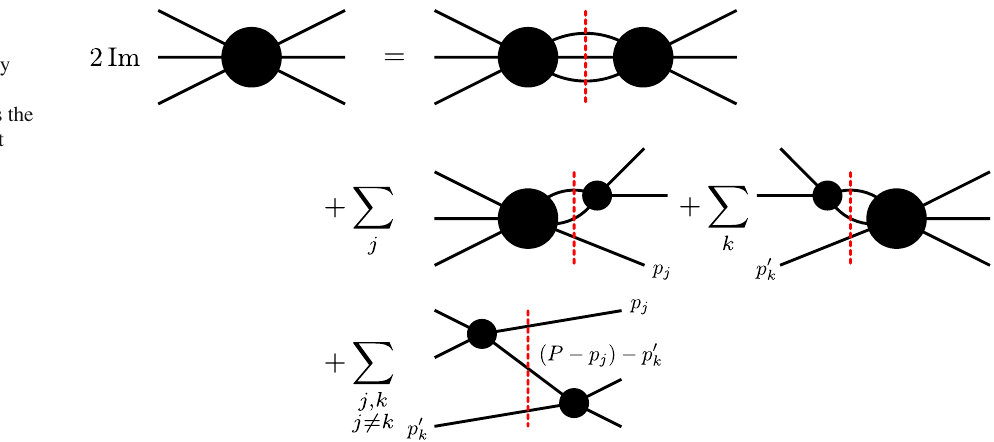
Fig. 5 Diagrammatic representation for the 3 → 3 connected amplitude unitarity relation in Eq. (8). The red vertical dashed line indicates the intermediate particles are put